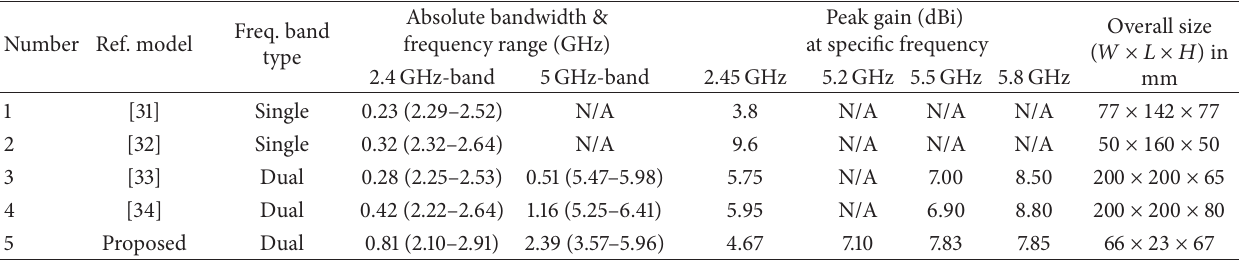
Table 3: Comparison of some bidirectional antennas used in the 2.4 GHz and/or 5 GHz WLAN bands. Number Ref.